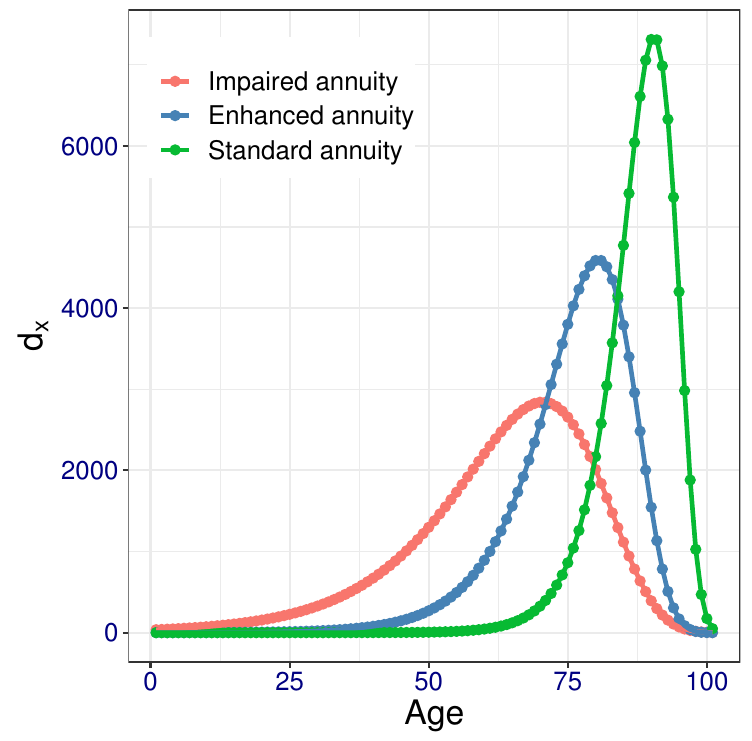
Figure 1. Curves of deaths for different life